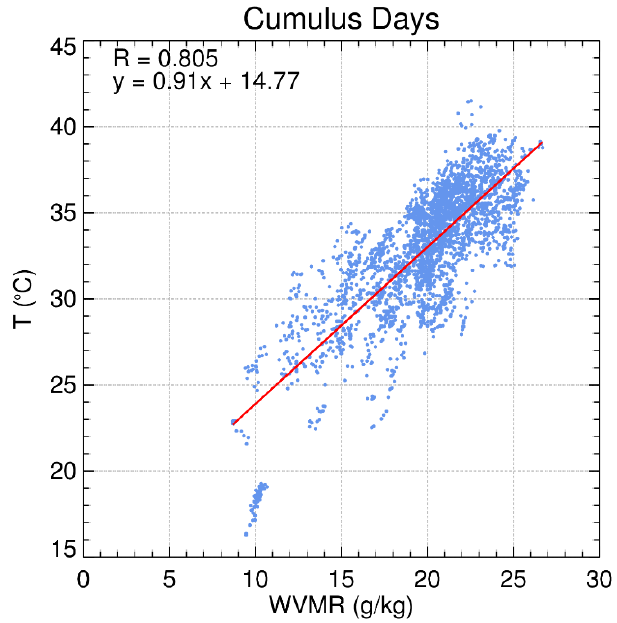
Figure 11. Scatterplot showing the relationship between surface air temperature (T) and water vapor mixing ratio (r) associated with 2744 shallow cumulus cloud events observed by our polarization lidar. Note that the shallow cumulus cloud events occurred mostly (>79%) when the near-surface temperature T was higher than 30° C and the WVMR larger than 15 g kg − 1 .